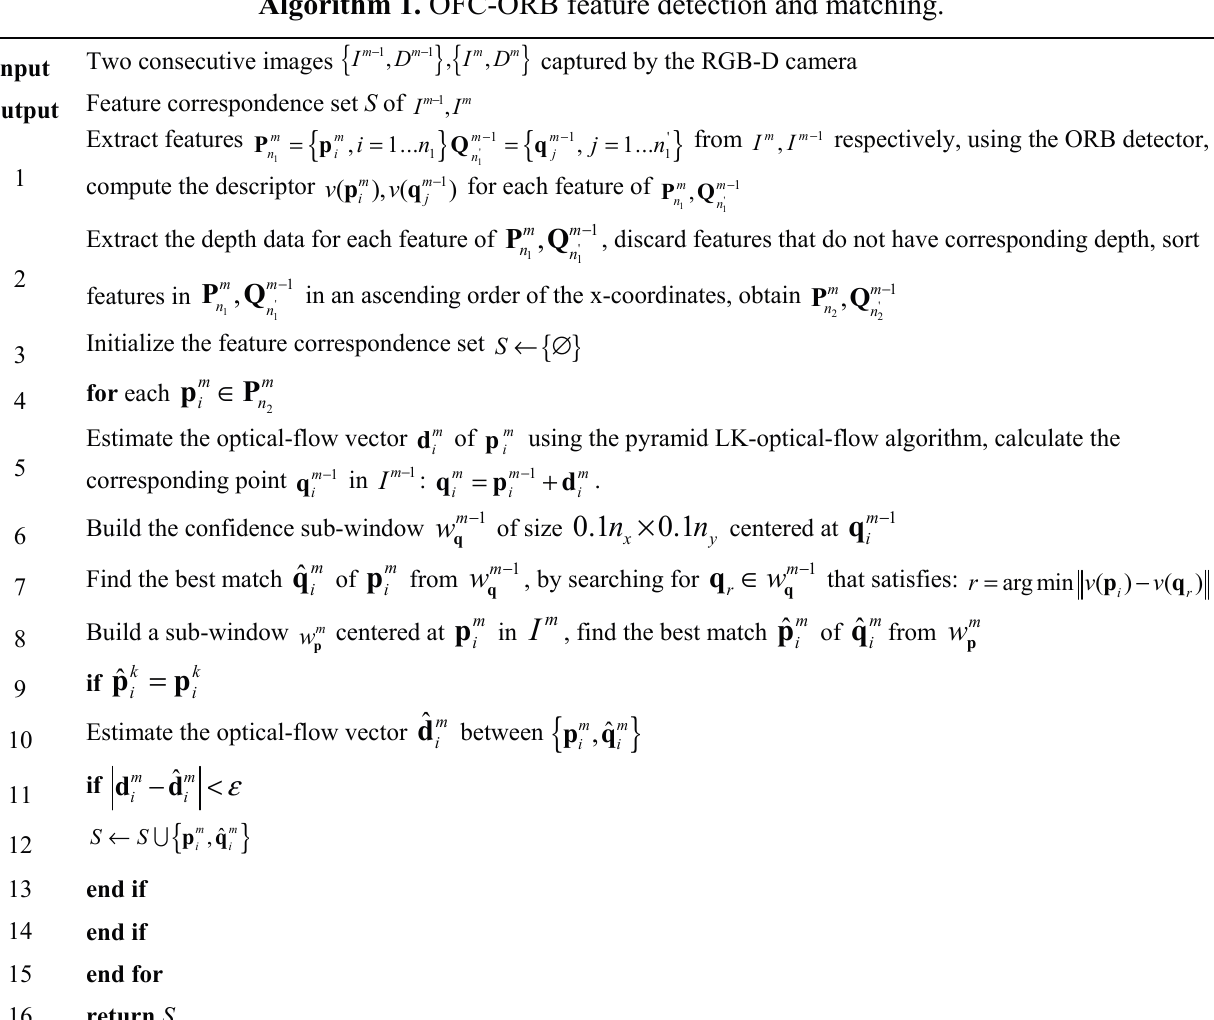
Algorithm 1. OFC-ORB feature detection and